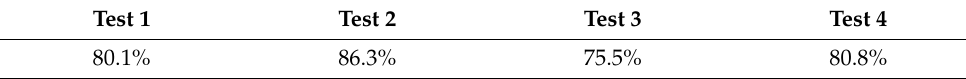
Table 8. Efficiency 1 : Results from four tests for the cycle list model.